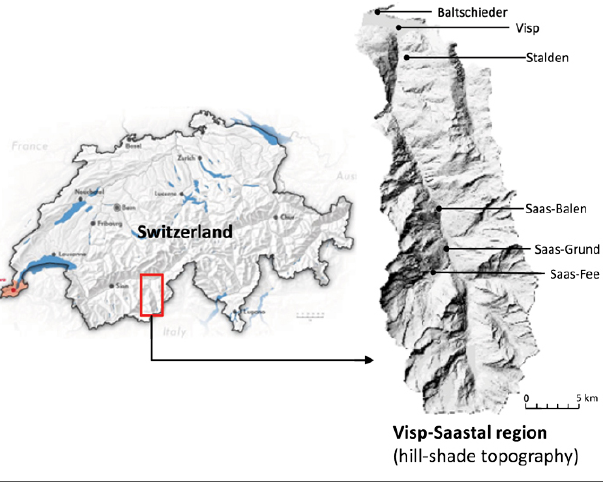
Fig. 1 . Geographic location and topographical map of the Visp region in the Upper Valais,